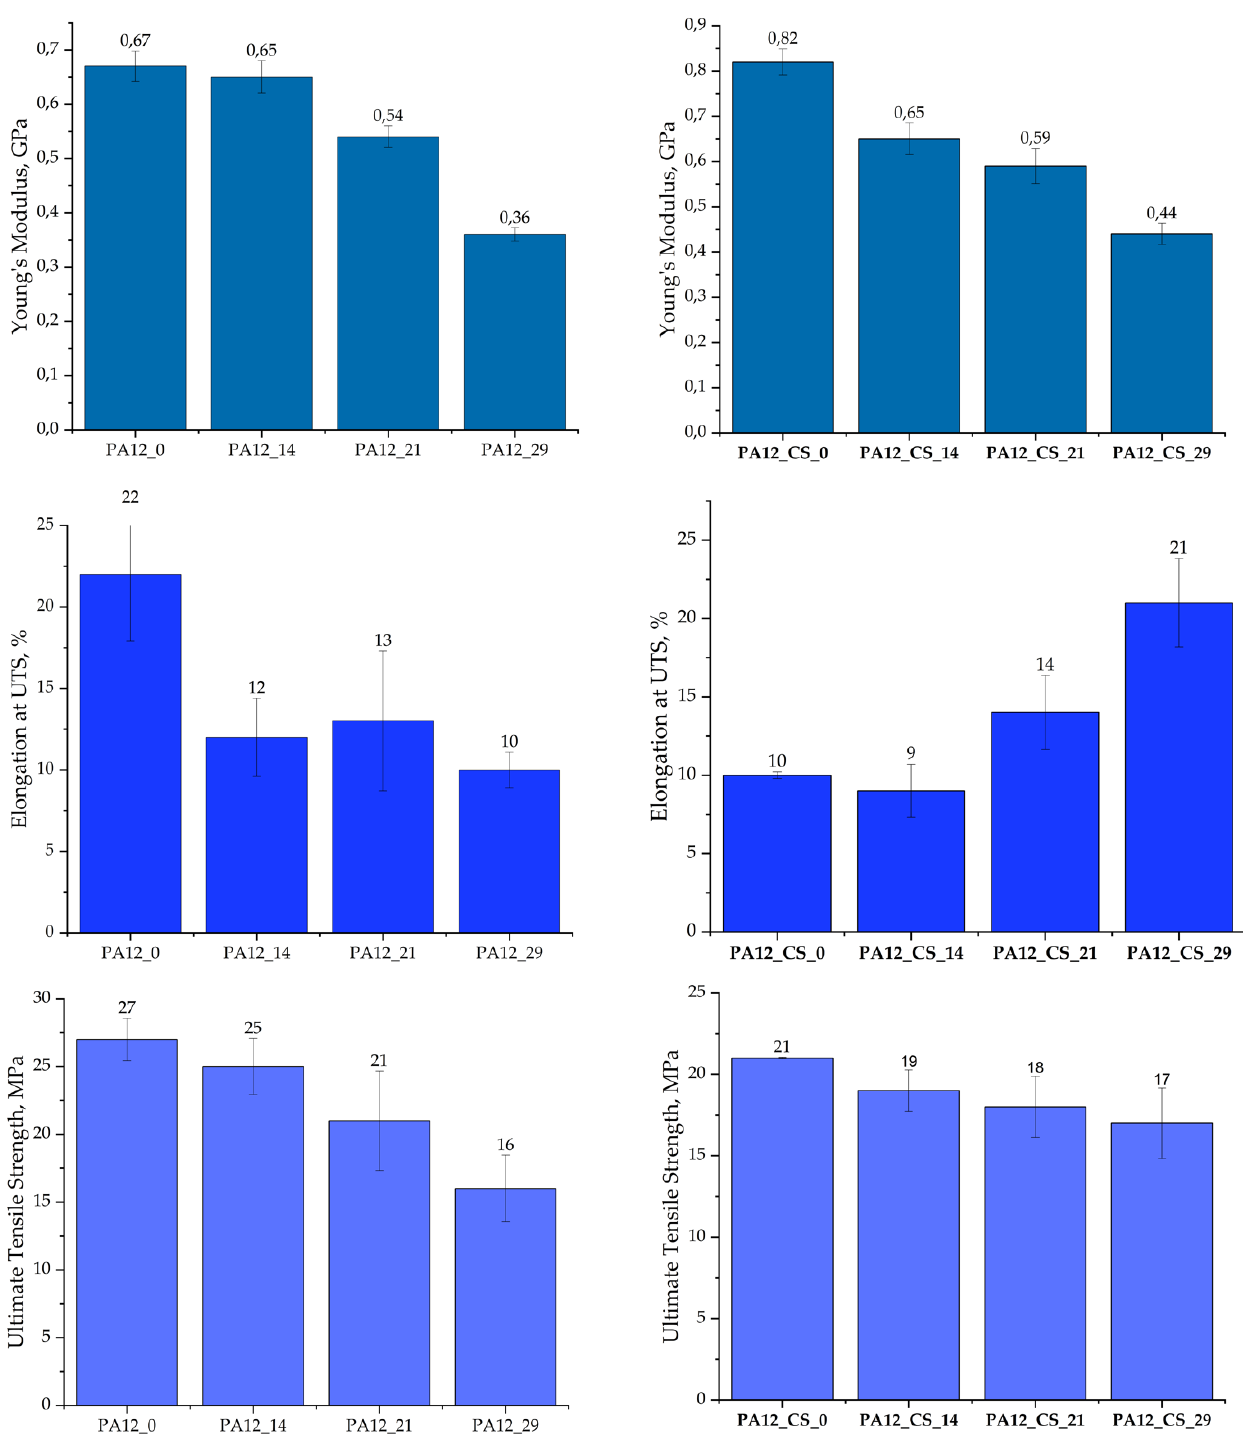
Figure 13. Young’s modulus, elongation at ultimate tensile strength, and ultimate tensile strength of the PA12 and PA12_CS in the initial state and after soaking in artificial saliva (SBF).